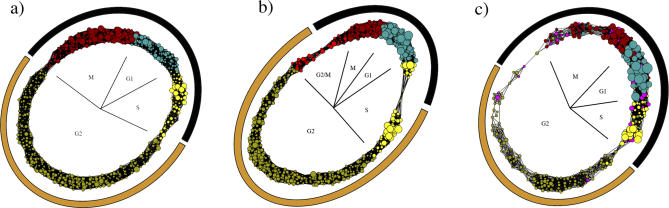
Networks of the Three Sets of Periodic Genes in S. pombe
Oliva et al. [8] (A), Peng et al. [7] (B), Rustici et al. [6] (C). Different colors identify genes assigned to different phases of the cell cycle. Pink nodes in Rustici et al. [6] correspond to genes that have been identified as periodic but not assigned to a specific cell cycle phase. The radius of each node has been set according to the amplitude of the corresponding gene at its expression peak. The black–orange circle provides a visual identification of the two main clusters (the black one and the orange one). This image has been realized with the graph drawing software Visone [30].